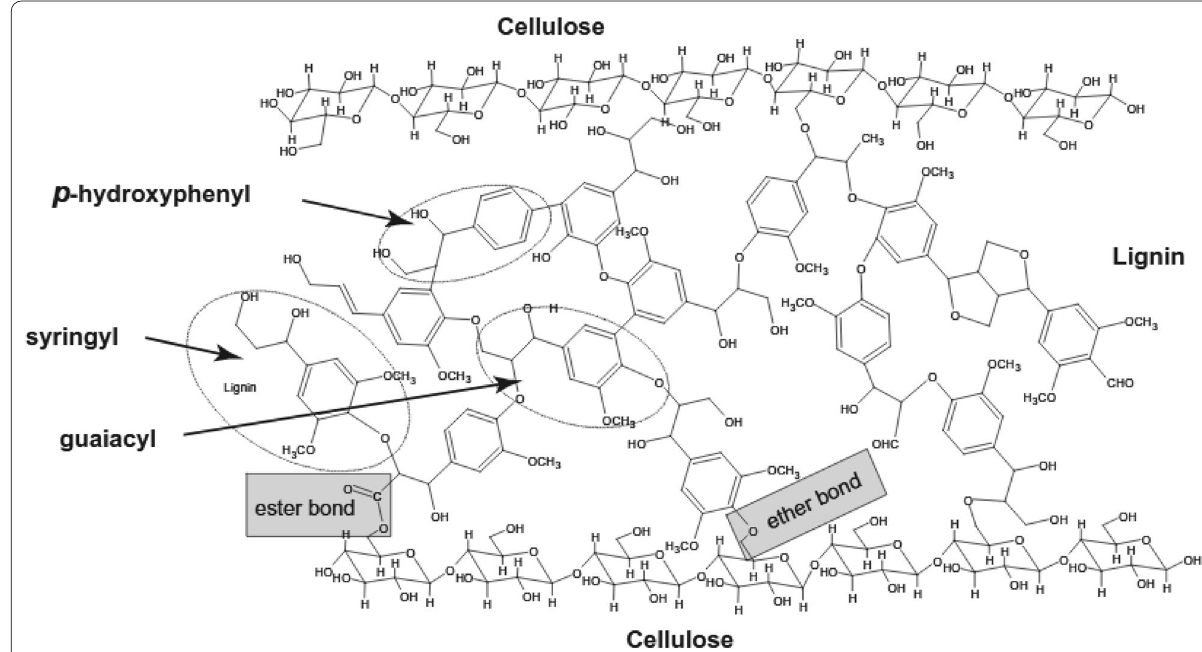
Fig. 3 Chemical linkages between lignin and cellulose (Maryana et al.